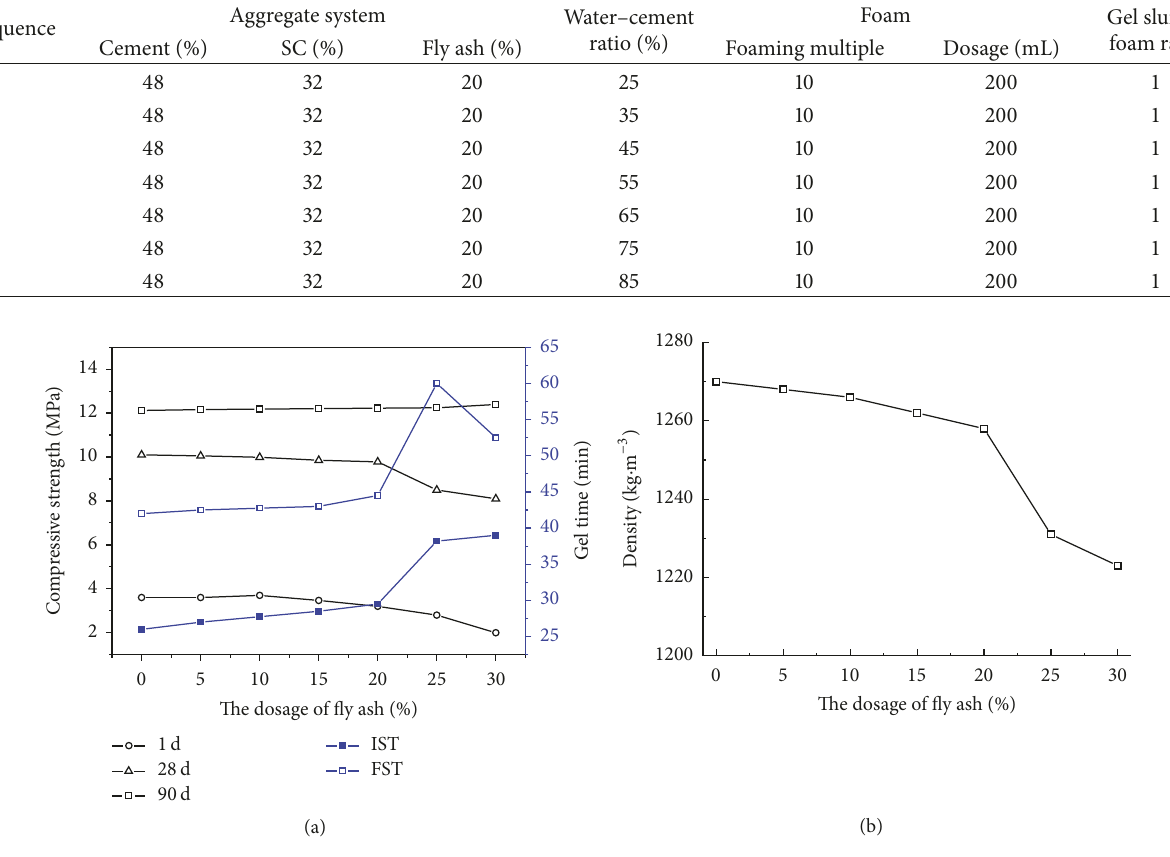
Figure 3: Effect of the dosage of fly ash on the filling